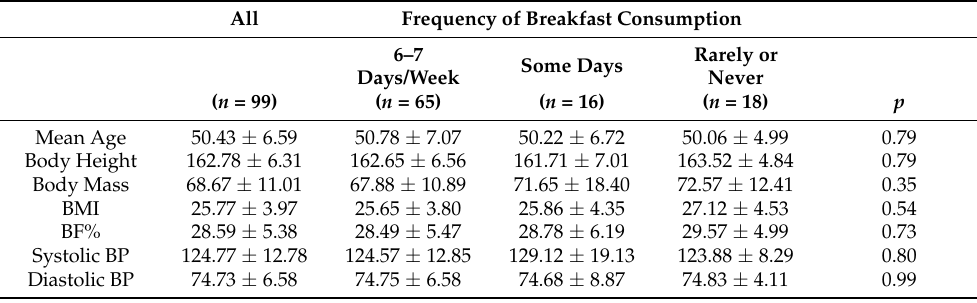
Table 1. Age, anthropometric data and blood pressure values of the study population according to frequency of breakfast consumption (mean ±